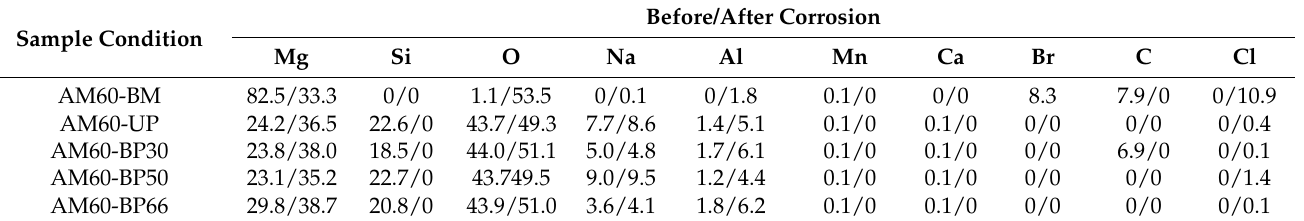
Table 2. Chemical composition of AM60 at different conditions determined by EDS analysis before and after corrosion (wt.%).